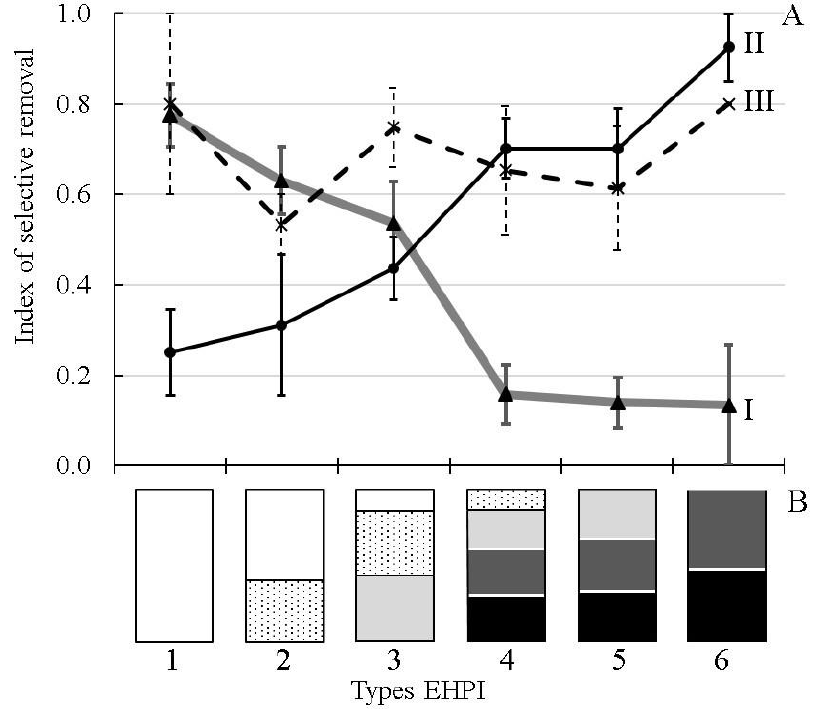
Figure 2. ( A )—Selective removal (SR-index) of fish from the water intake zones of the water bodies with different types of the Eco-Hydraulic Patterns of Interaction (EHPI) between water flow and ecological zones. Average values of SR-indices for three ecological groups of fishes: I—Littoral, II—Pelagic, III—Ubiquitous, are shown against different types of EHPI ( B , see Figure 1). Observed trends for the different groups of fishes significantly differ (Kruskal–Wallis H test: H 14,69 = 43.0; p = 0.0001). Data from [34,37]. See Tables S2–S4 for more details.